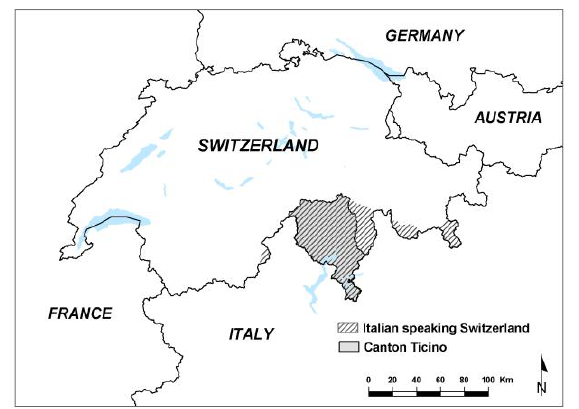
Figure 1: The Italian-speaking part of Switzerland and the territory of the Canton Ticino where the Repertorio toponomastico ticinese deals with collecting and cataloguing the toponymic heritage since 1960.